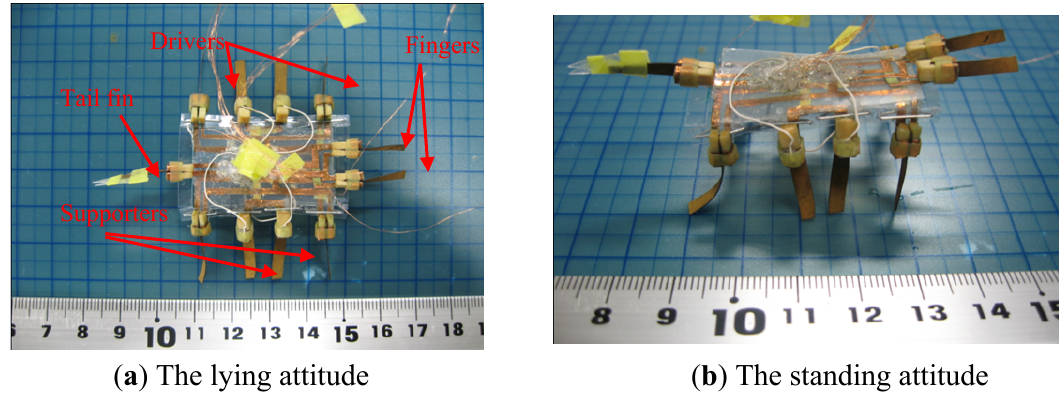
Figure 20. The prototype microrobot (in